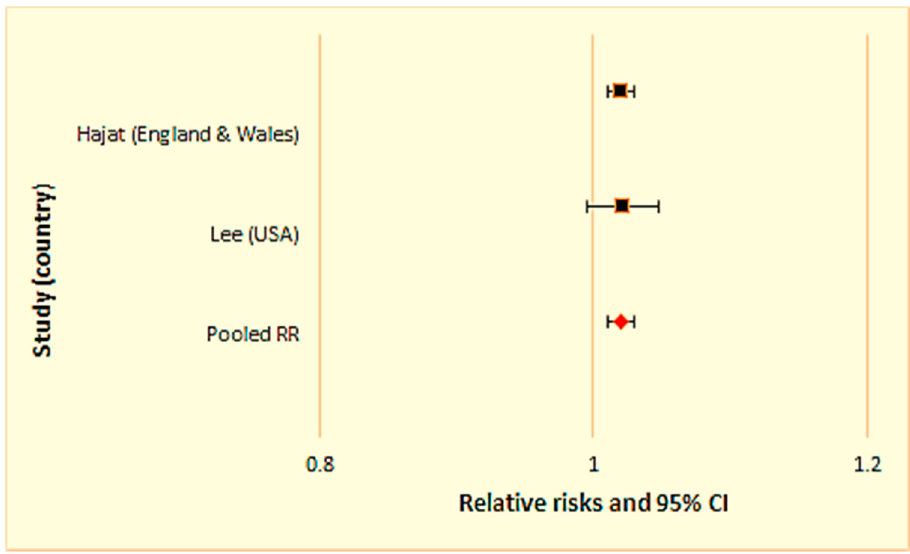
Figure 6. Sensitivity analysis for studies conducted in developed countries. Table 5. Effect size estimates of studies in developed countries. Study (Country) Effect Size (95% Confidence Interval) %